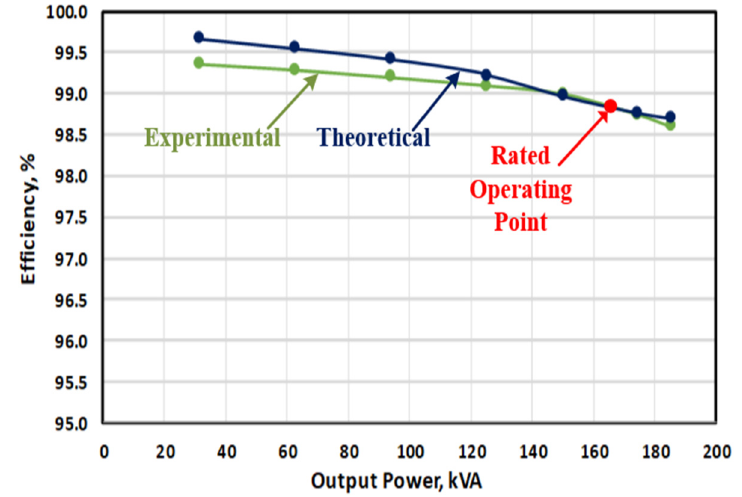
Figure 17. Percent efficiency of traction inverter against traction motor input kVA at rated speed of 1779 rpm when V dc = 750 V, V AB = 480 V rms, and f s = 60 Hz.